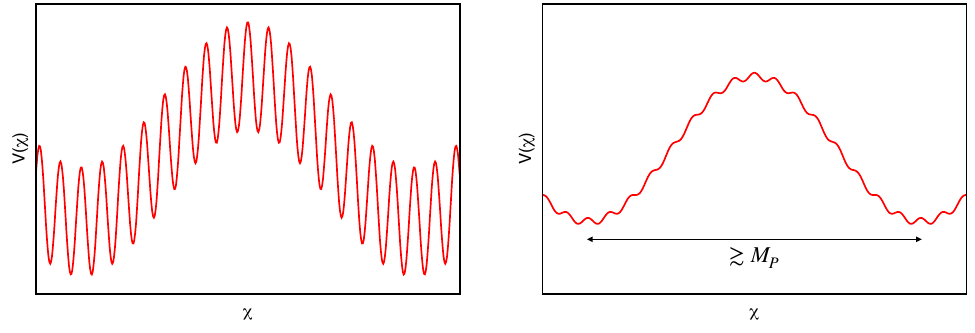
Figure 8 . Examples of axion potentials with a large (cid:12)eld range. The potential on the right-hand side has a large monotonic region as required by